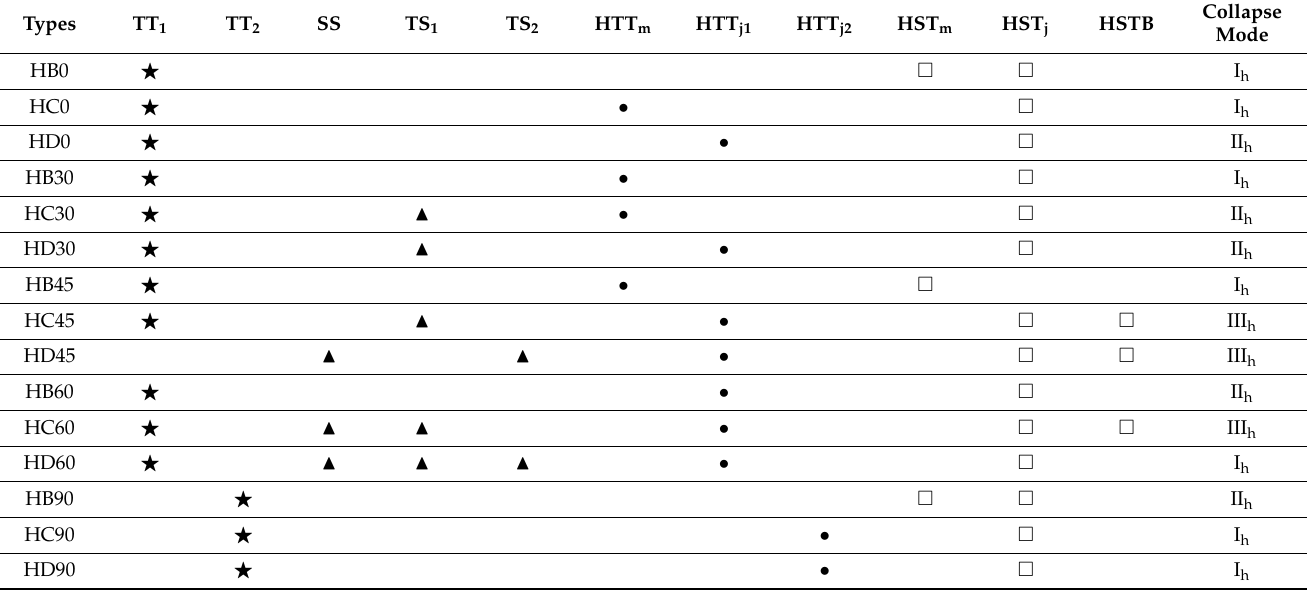
Table 3. Crack coalescence types and collapse modes of the hole observed in the jointed specimens with a hole (Symbols (cid:70) and (cid:78) represent crack coalescence types between the joints without or with participation of shear crack, respectively; • and (cid:3) represent crack coalescence types between the hole and the joint or matrix without or with participation of shear crack,